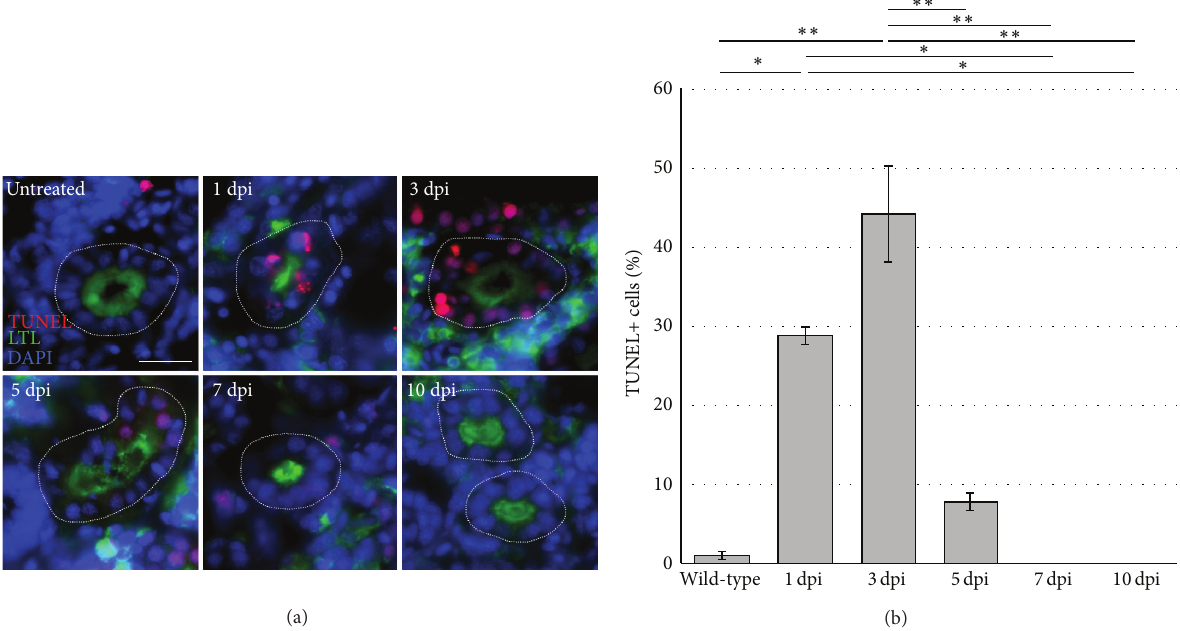
Figure 4: Detection of proximal tubule cell death after gentamicin injury. (a) Kidney tissue was assayed for TUNEL-positive cells in uninjured kidneys and at 1, 3, 5, 7, and 10dpi. The peak of TUNEL reactivity in cells was identified within LTL-positive proximal tubules at 1, 3, and 5 days after kidney injury. By 7 and 10 days, the level of TUNEL-positive cells decreased, returning to basal levels previously established in untreated kidneys. Proximal tubules were labeled by LTL. (b) Quantification of TUNEL labeling in nephron proximal segments. Scale bar, 25 𝜇 m. Labels: ∗ indicates 𝑃 < 0.05 ; ∗∗ indicates 𝑃 < 0.01